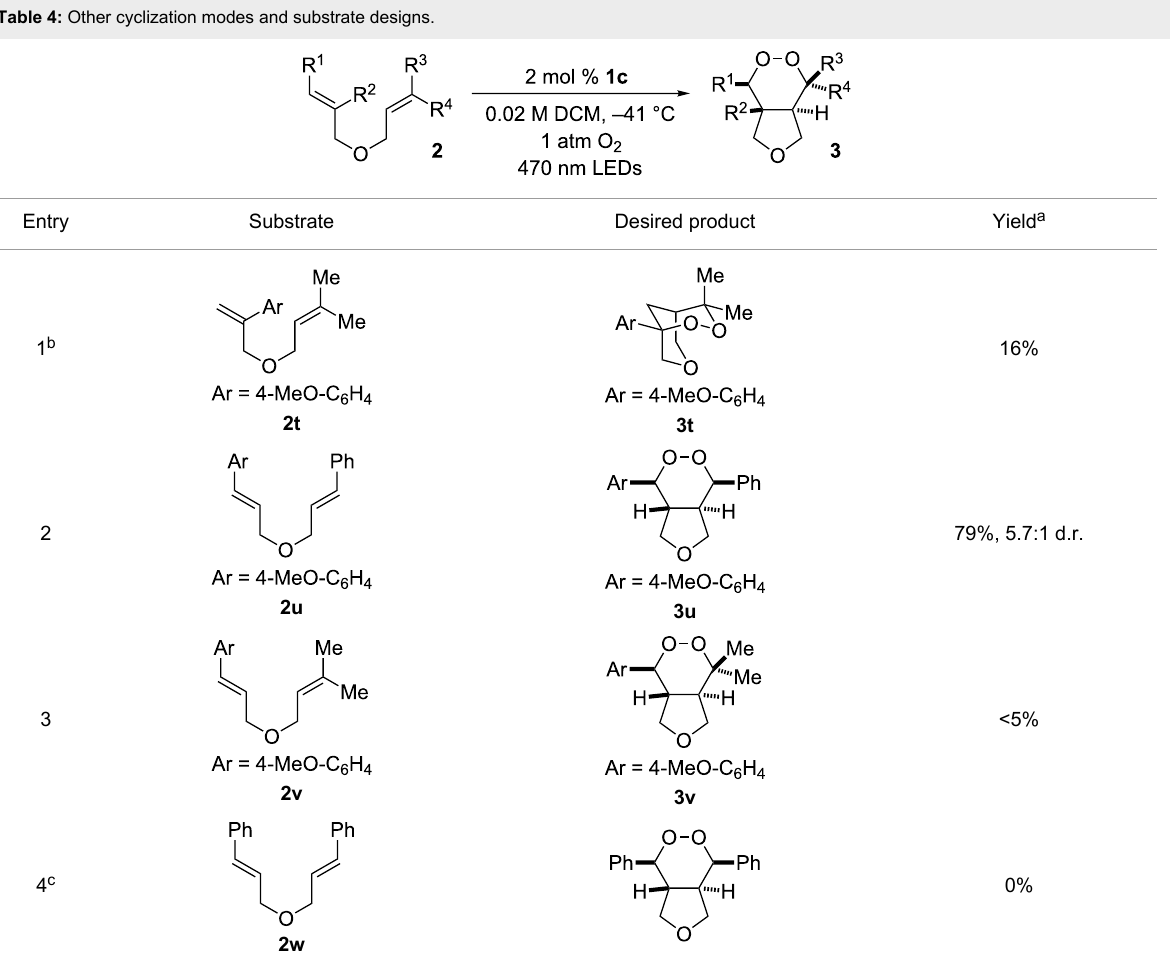
Table 4: Other cyclization modes and substrate